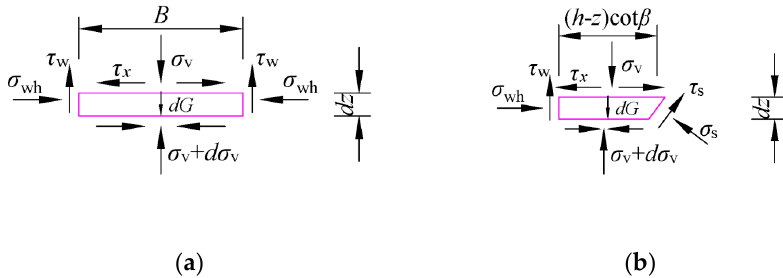
Figure 7. Force analysis of horizontal soil strip of ( a ) rectangular type and ( b ) trapezoidal type.